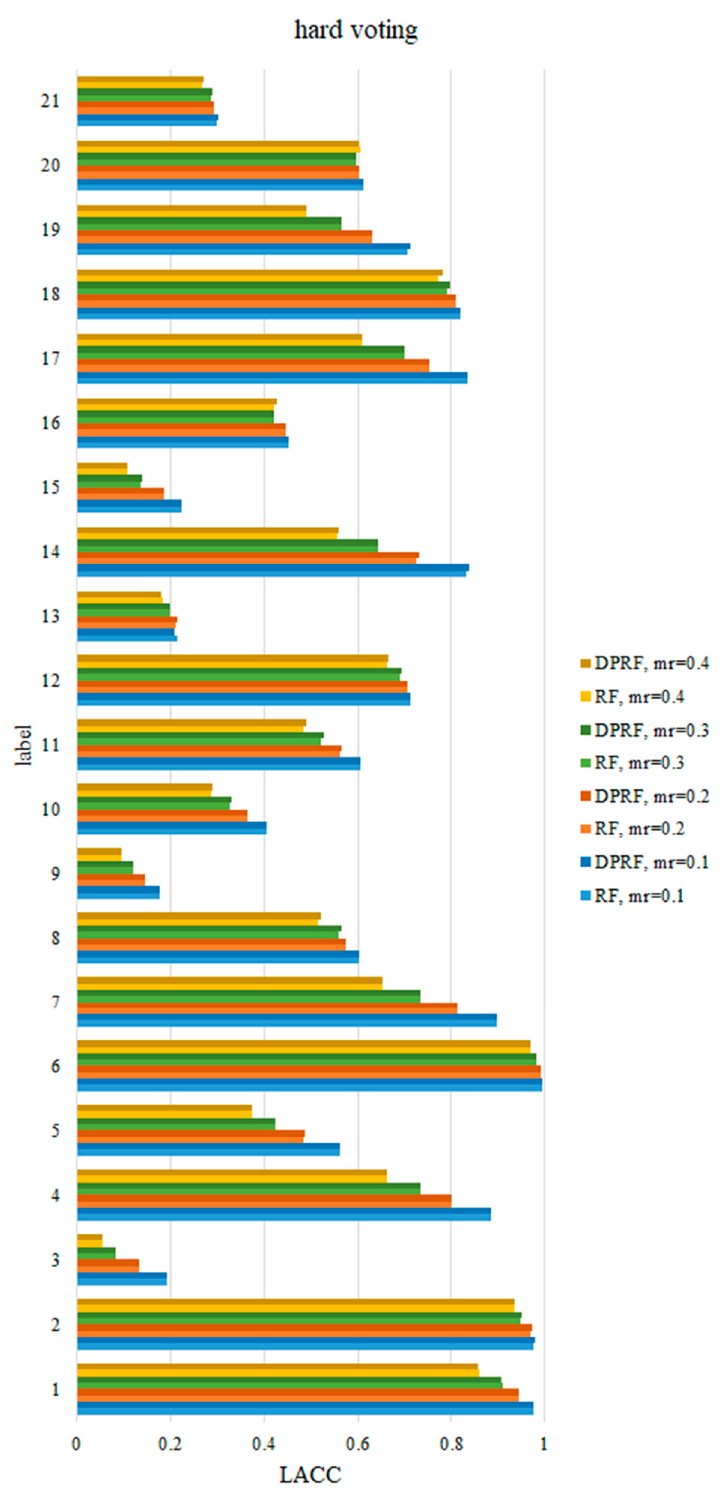
Figure 5. Comparison of LACC of RF and DPRF at different missing rates based on hard